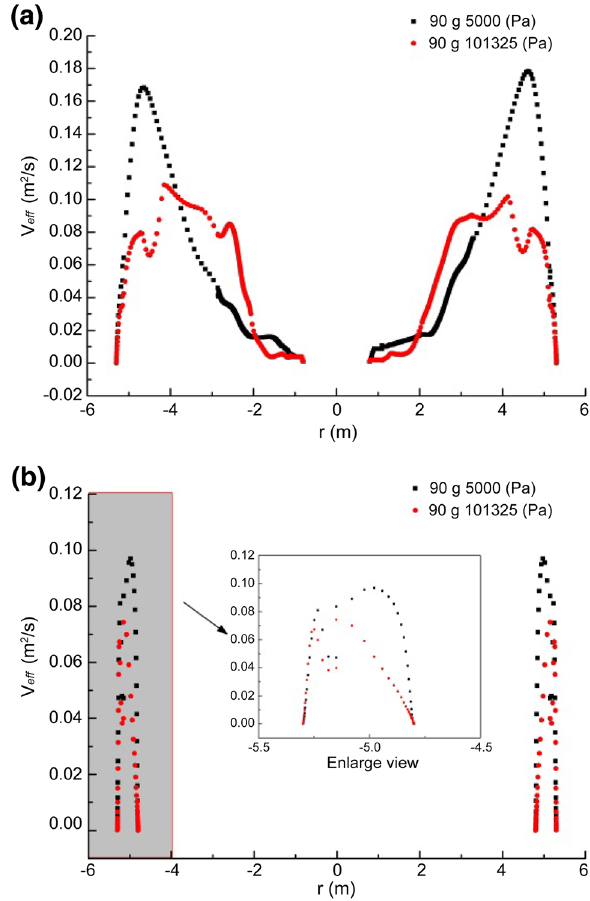
Fig. 13 Effective kinematic viscosity comparison diagram for lines a one and b two